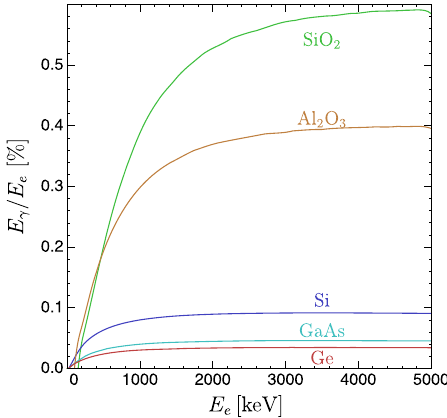
FIG. 6. Electron mean range Eq. (2.7) in Si, obtained from Ref. [122]. Horizontal lines indicate an electron mean range of 15 and 900 μ m, which corresponds to the size of 1 and 60 pixels, respectively, of the Skipper CCDs used by SENSEI (see Sec. V).